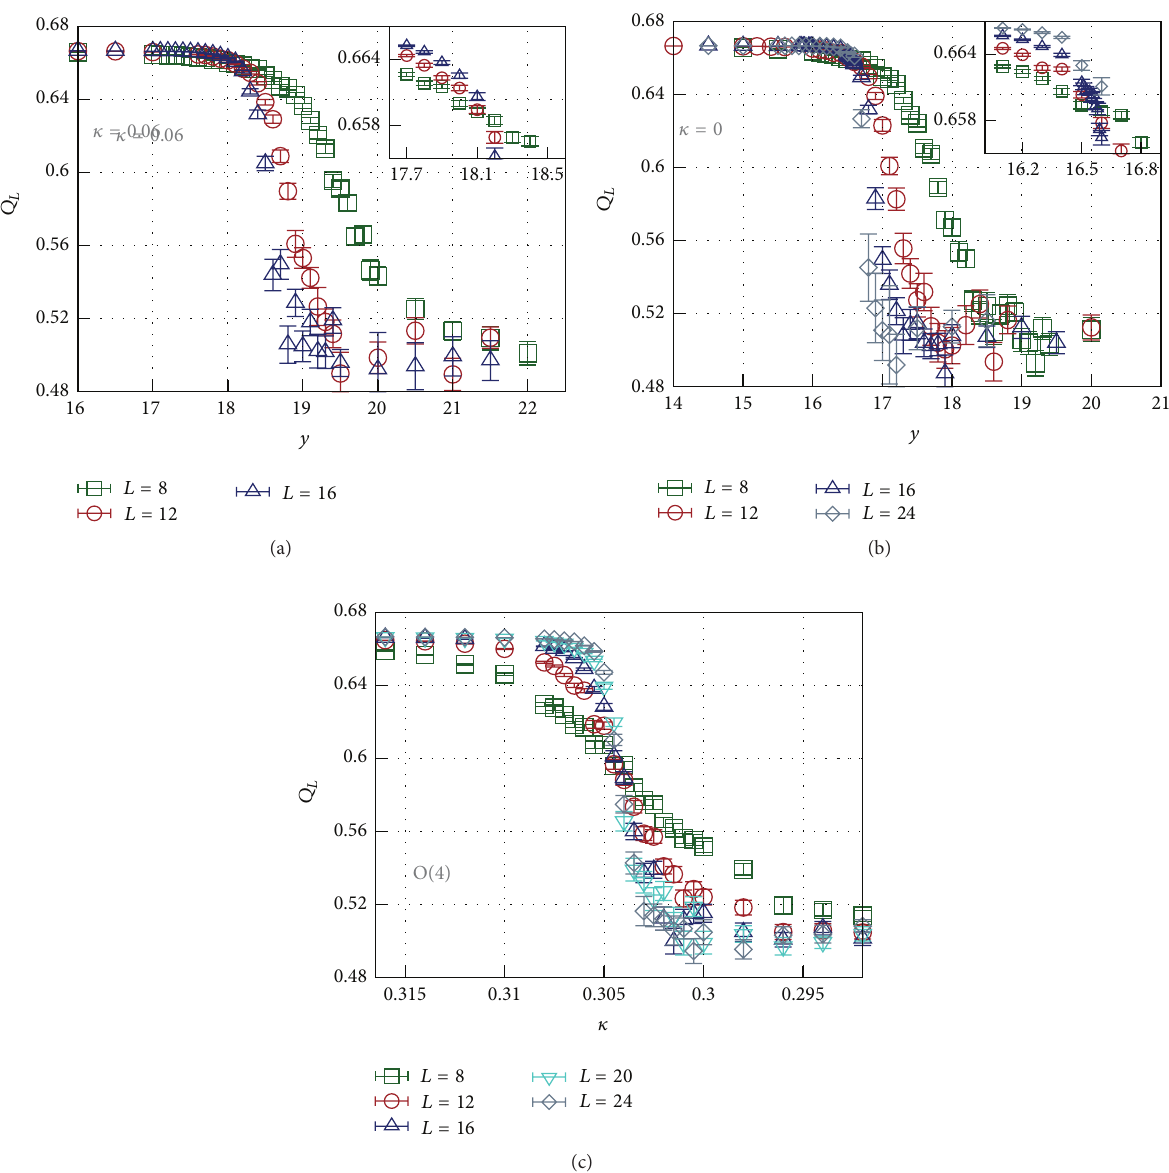
Figure 10: Binder’s cumulant 𝑄 𝐿 at 𝜅 = 0.06 (a), 𝜅 = 0.00 (b), and the O (4) model (c) for various volumes where the subscript 𝐿 indicates the finite volume quantity. Note that the value of 𝑄 𝐿 at the critical point is different in the Higgs-Yukawa and the O(4) models.